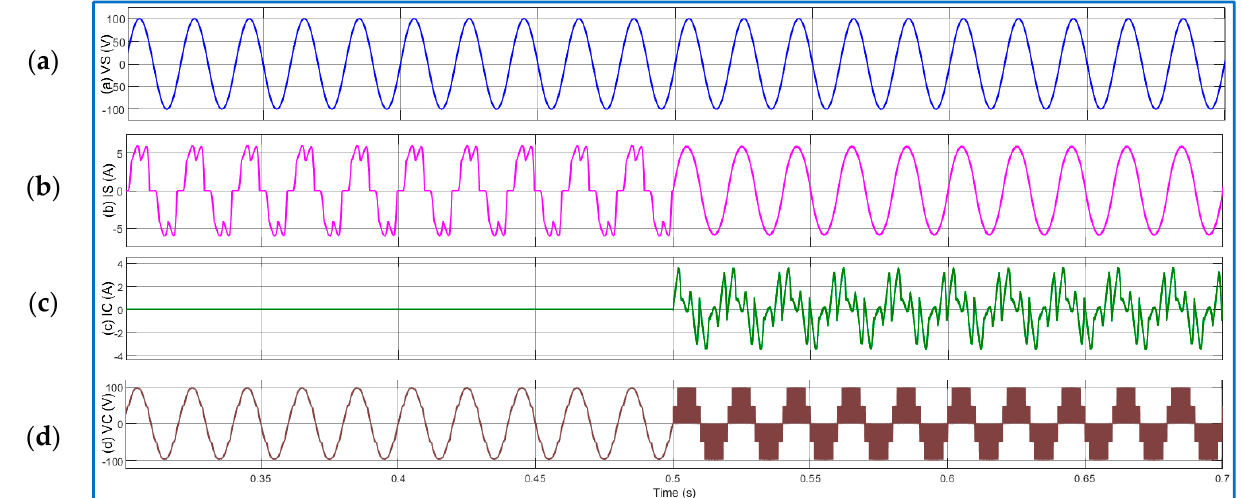
Figure 11. Single phase: ( a ) VS: supply voltage; ( b ) IS: supply current; ( c ) IC: compensator current; ( d ) VC: compensator voltage.